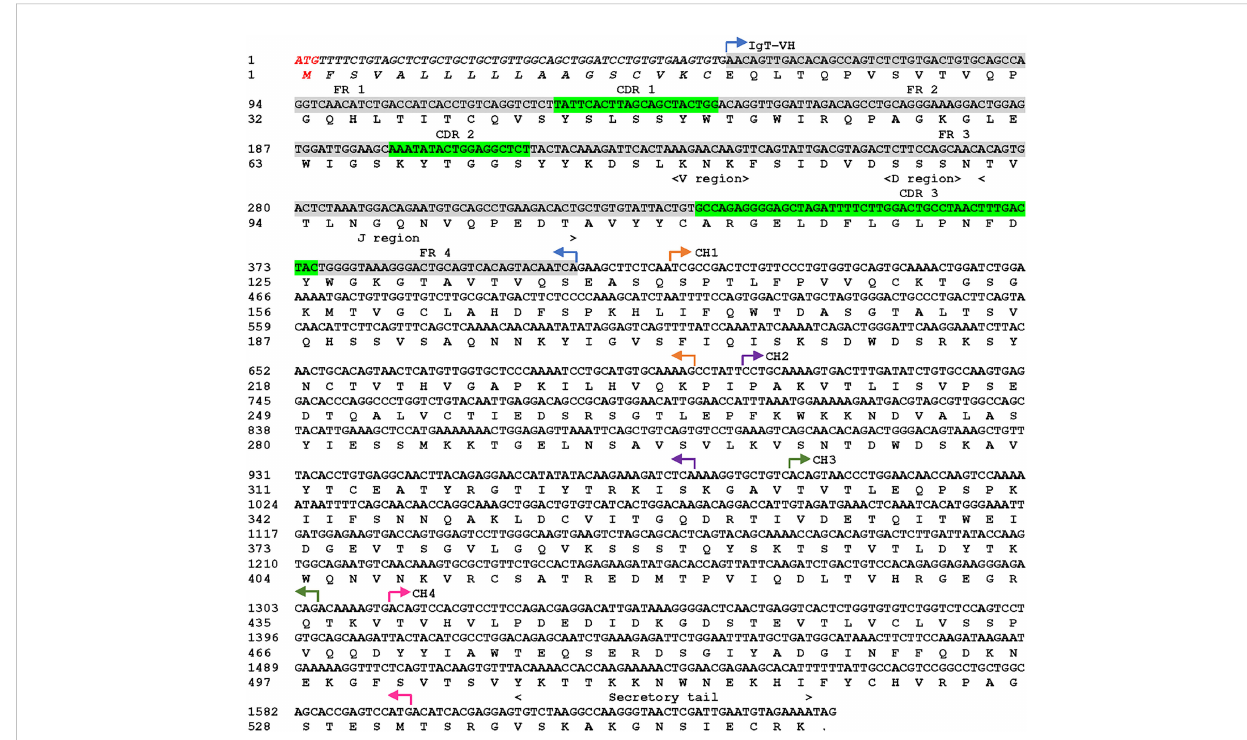
FIGURE 1 Asian seabass ( L. calcarifer ) secreted form of IgT nucleotide and amino acid sequence (sIgT, GenBank accession number OQ108524). The VH, predicted VDJ segment, four CH regions (CH1, CH2, CH3 and CH4) and C-terminal secretory tail are depicted in the sequence. The predicted signal sequence of ASB sIgT heavy chain is in italics, framework region (FR) and complementarity determining region (CDR) were highlighted in grey and green